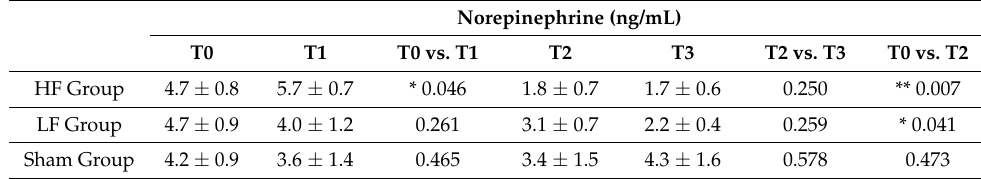
Table 2. Acute and chronic variations of norepinephrine levels. Data are shown as mean ± standard error of the mean (SEM). Average values of norepinephrine ± SEM are reported at baseline (T0), after the first dTMS session (T1), before (T2), and after the last (15th) dTMS session (T3) for all three groups (HF, high frequency 18 Hz; LF, low frequency 1 Hz; sham). Comparisons at different times (T0 vs. T1, T2 vs. T3, T0 vs. T2) were obtained with two-tailed Student’s t -tests. For all tests, differences were considered statistically significant at p ≤ 0.05. Legend: HF = high frequency; LF = low frequency; * p < 0.05; ** p <